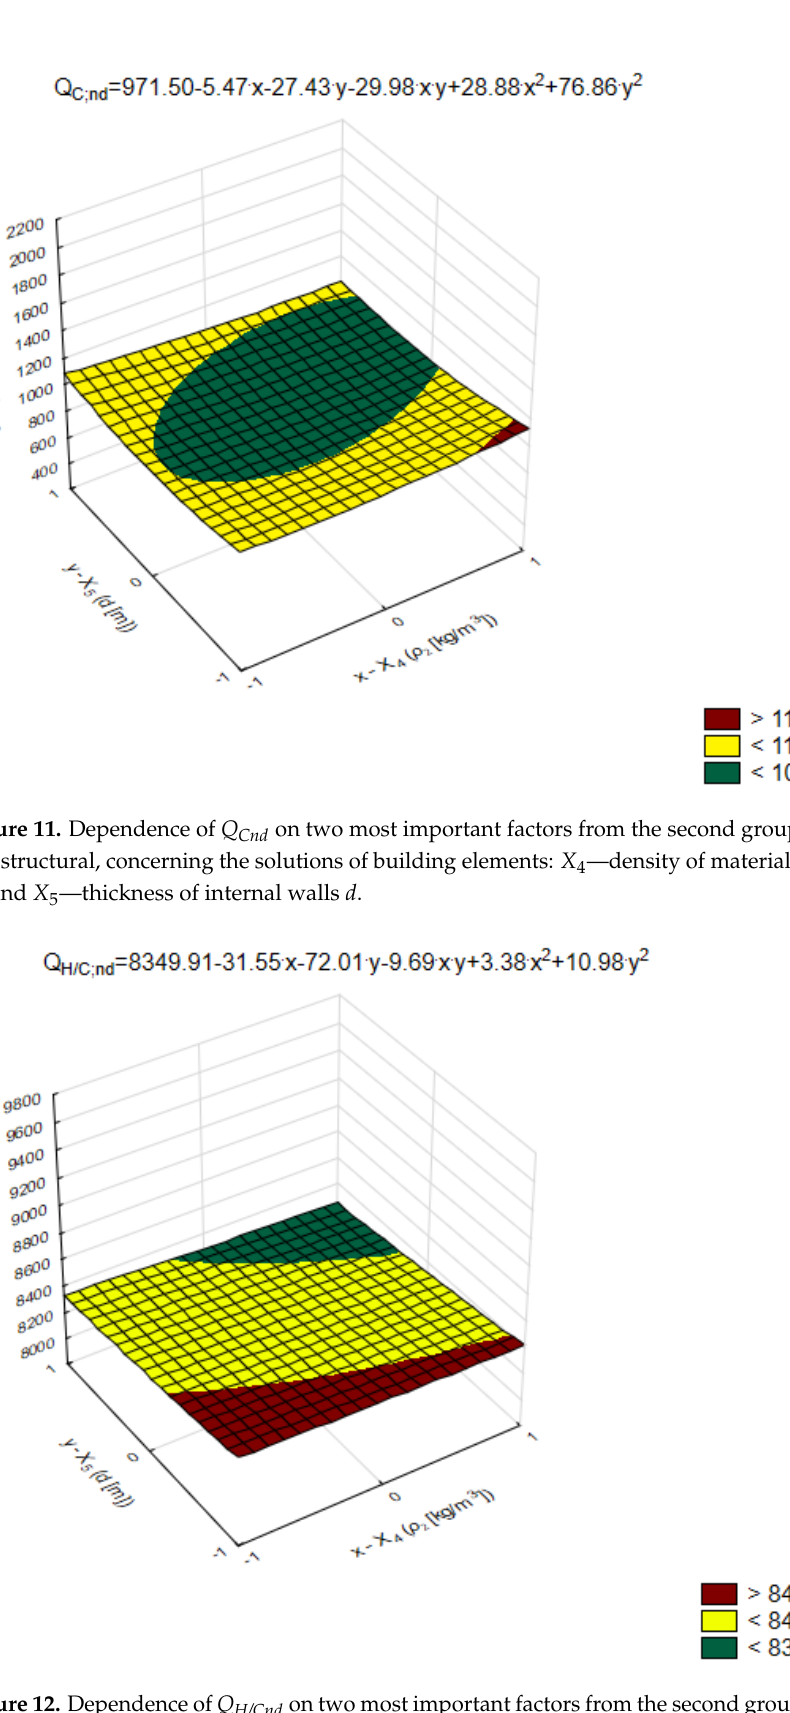
Figure 12 Figure 12. Dependence of Q H/Cnd on two most important factors from the second group of parameters, i.e., structural, concerning the solutions of building elements: X 4 —density of material of internal wall ρ 2 and X 5 —thickness of internal walls d